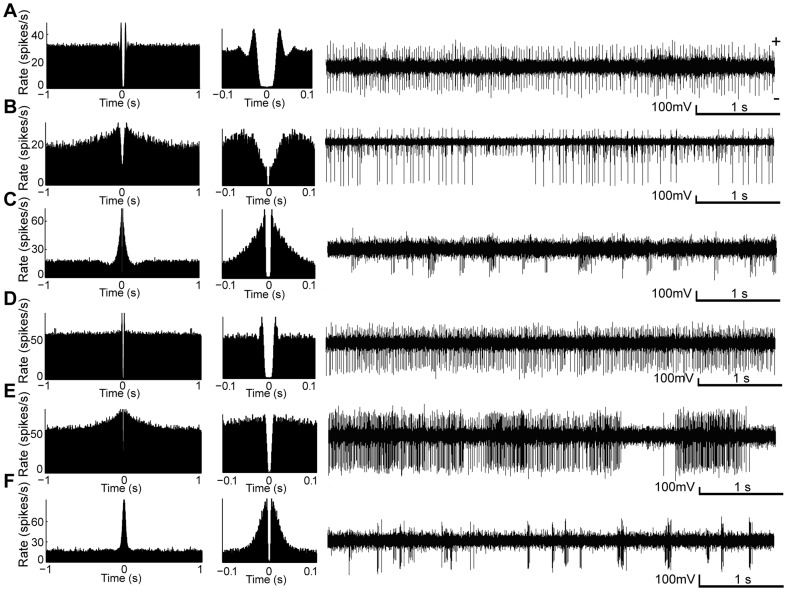
Typical firing patterns observed in rats (A–C) and primates (D–F).Left panel: autocorrelation using a time window of ±1 s, middle panel: autocorrelation with x-axis expanded to ±0.1 s, right panel: spike train of the example neuron. A: example of HFP neuron exhibiting tonic Poisson firing without pauses. B: HFP neuron displaying pauses (pauser). C: LFB neuron (burster). D–F: same type of neurons as in A–C but in primates.